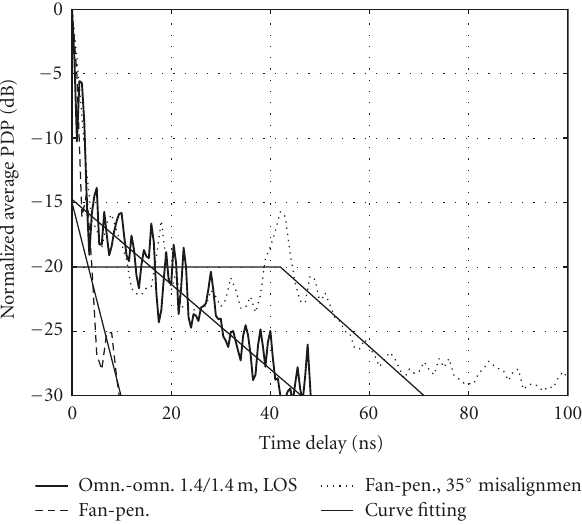
Figure 6: Average power delay profiles and curve fittings for the Fan-Omn/Fan/Pen